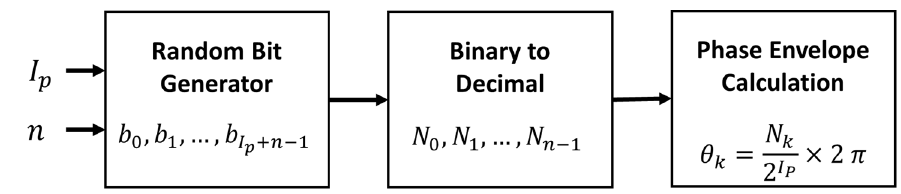
Figure 3. Phase-modifying factor generation process.